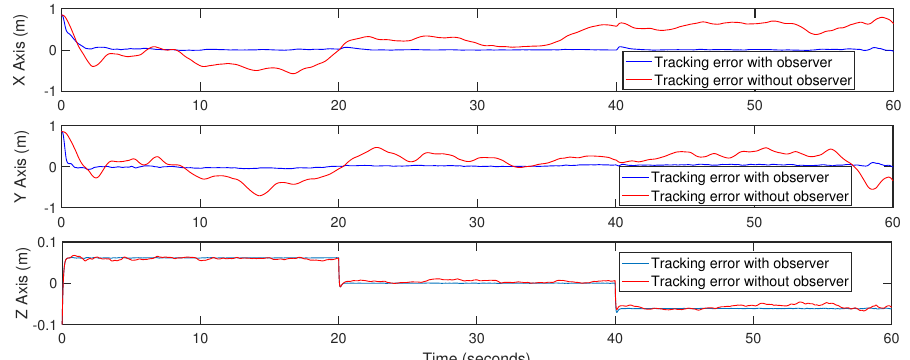
Figure 25. Position tracking error when Von Karman wind turbulence model is applied to the attitude